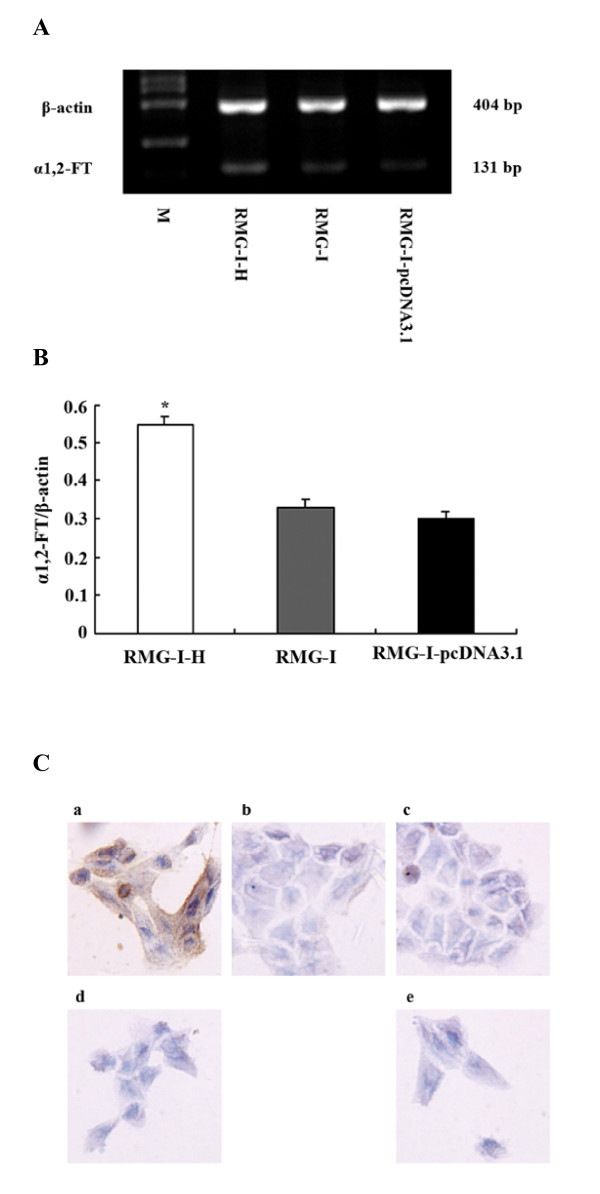
Characterization of α1,2-FT-transfected cell lines. (A) RT-PCR profiles of α1,2-FT mRNA in non- and α1,2-FT-transfected cells. M: DNA ladder marker (100-2000 bp). (B) Relative expression of α1,2-FT mRNA in non- and α1,2-FT-transfected cells (n = 3). The data was expressed as the intensity ratio of α1,2-FT to β-actin (Mean ± SD). * p < 0.01 compared to the control. "A" is the representative of three independent and reproducible experiments. (C) Immunohistochemical staining for Lewis y antigen. (a) RMG-I-H cells; (b) RMG-I-pcDNA3.1 cells; (c) RMG-I cells; (d) RMG-I-H-A cells; (e) RMG-I-A cells. Meanwhile, a, b and c represents cells without α-L-fucosidase treatmeant; d and e represents cells with α-L-fucosidase treatmeant.